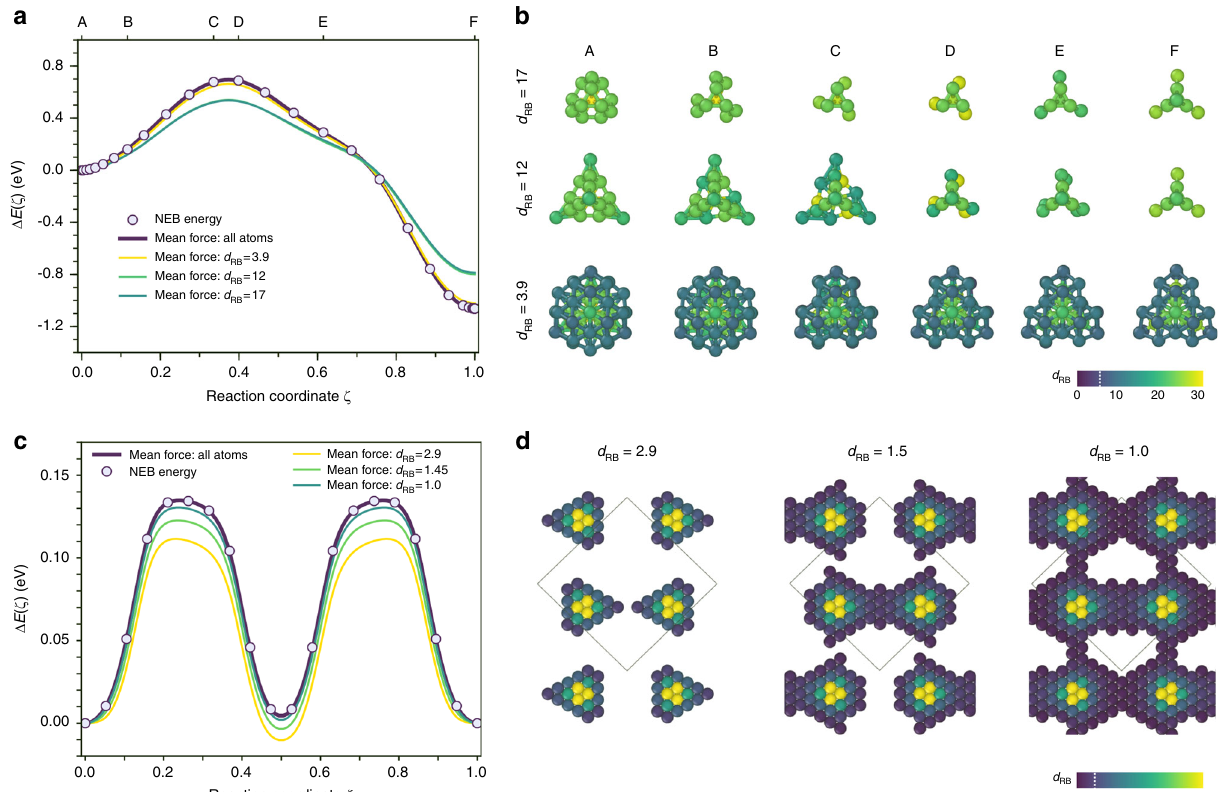
! I NP SIA transition pathway in bcc Fe. 2 2 ! I NP transition path provided 2 2 h 111 i dislocation dipole glide in {110} plane in bcc Fe. 2